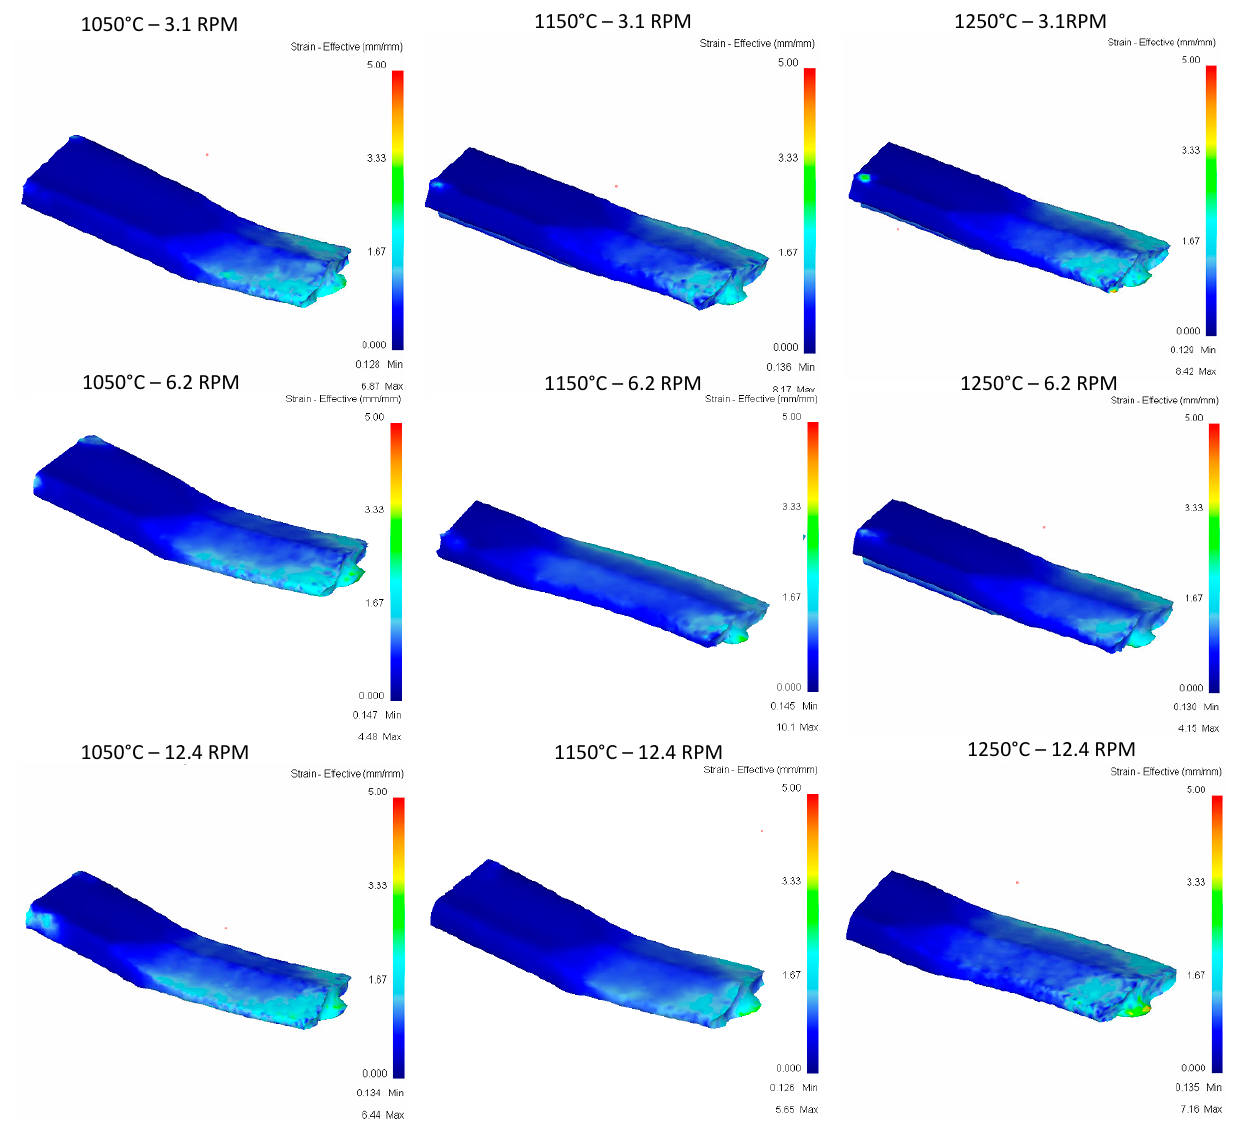
Figure 14. Effective Stress in the top Rail after second pass. For the temperature graph shown in Figure 15, in the evaluation of the second pass of the upper rail, homogeneous temperature conditions in the piece can be mentioned, where no hot spots are observed derived from the concentration of temperature in specific points.